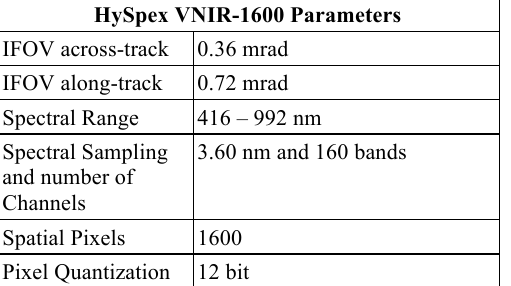
Table 3. Parameters of the HySpex instrument